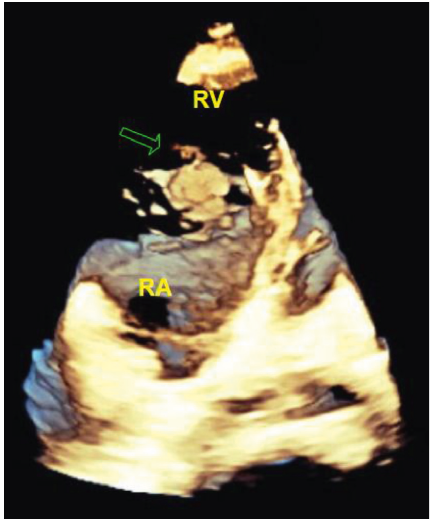
Figure 3: Three-dimensional image showing the tricuspid valve vegetation.